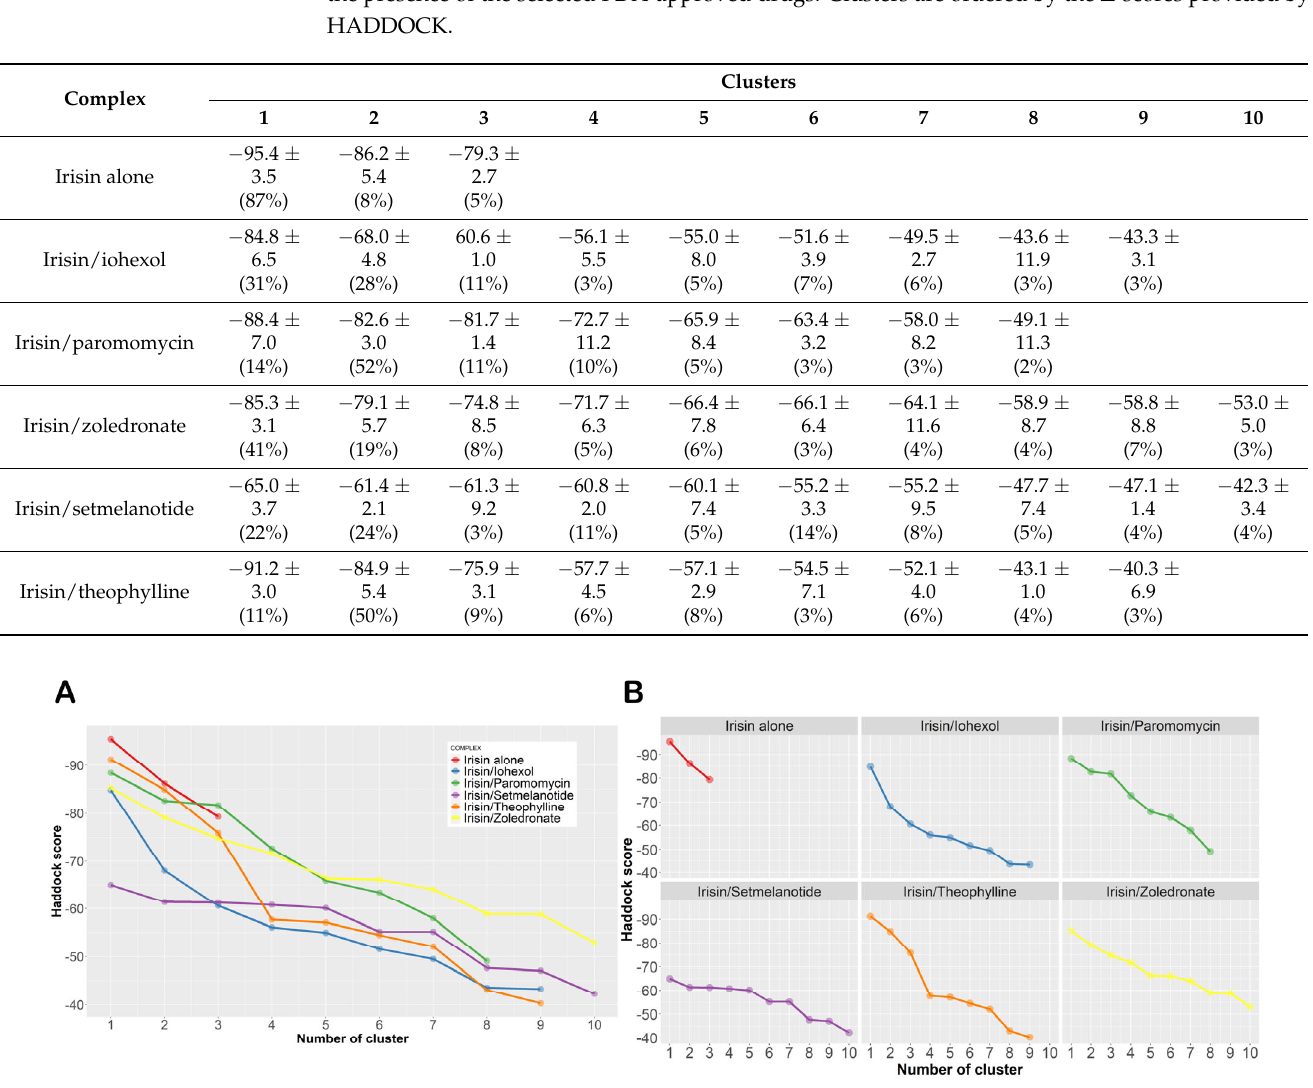
Figure 13. ( A ) Graphical representation of the HADDOCK outputs considering the data reported in Table 4. ( B ) Individual graphs for each studied